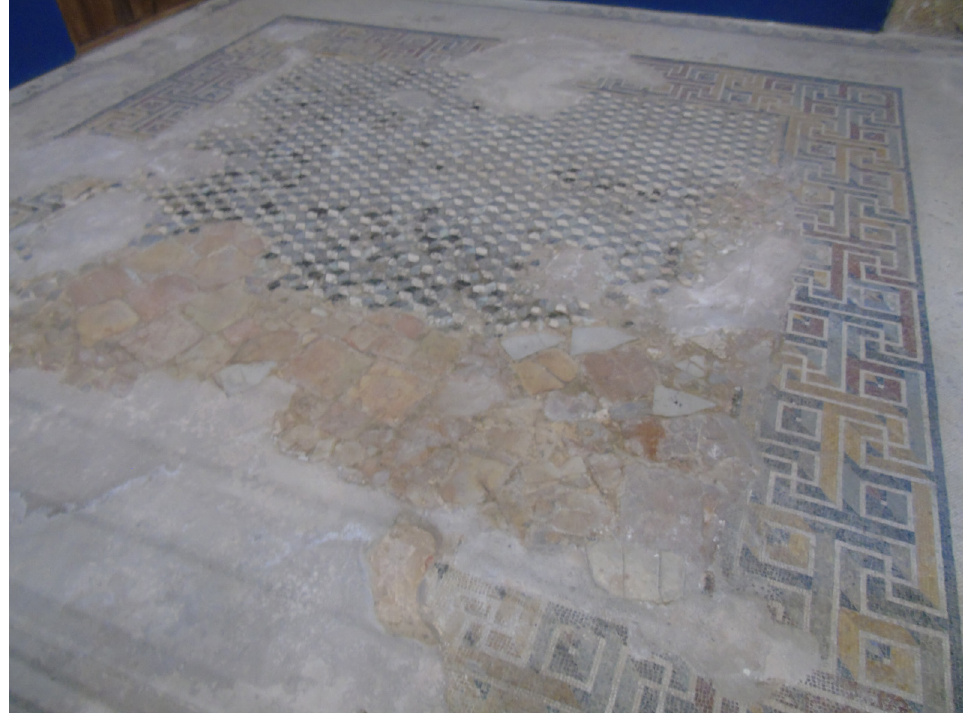
Figure 9: Repaired mosaic from the Domus Romana (Photo: author, courtesy of Heritage